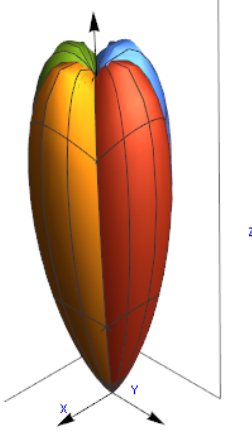
Figure 4. Squinted Gaussian power